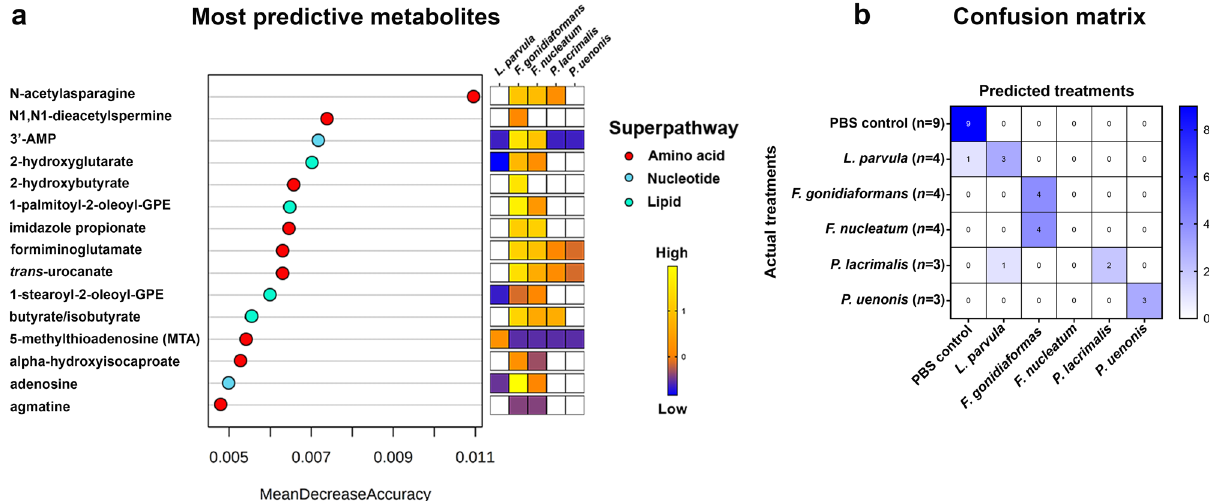
Fig. 4 Random Forest classi fi cation identi fi es metabolites within amino acid, nucleotide, and lipid superpathways that discriminate infections with BV- associated bacteria in 3-D cervical cells. a Metabolites most predictive of infection with L. parvula, F. gonidiaformans, F. nucleatum, P. lacrimalis , and P. uenonis include acetylated amino acid derivatives ( N -acetylasparagine and N 1, N 1-diacetylspermine), histidine catabolites (imidazole propionate, formiminoglutamate, and trans -urocanate), adenosine derivatives (3 ’ -AMP and adenosine), glycerophospholipids (1-palmitoyl-2-oleyol-GPE and 1-stearoyl- 2-oleoyl-GPE), oncometabolite (2-hydroxyglutarate), polyamines (MTA and agmatine), and short-chain fatty acids (2-hydroxybutyrate, butyrate/ isobutyrate, and alpha-hydroxyisocaproate). Only signi fi cantly different metabolites (infection vs. mock-infected controls) are colored in the heat map. b Random Forest confusion matrix. Individual cells are labeled according to how the algorithm predicted each treatment. Uninfected mock controls and infection with F. gonidiaformans, F. nucleatum , and P. uenonis were perfectly predicted. The number of replicates ( n ) included for each treatment are indicated in parentheses on the vertical axis